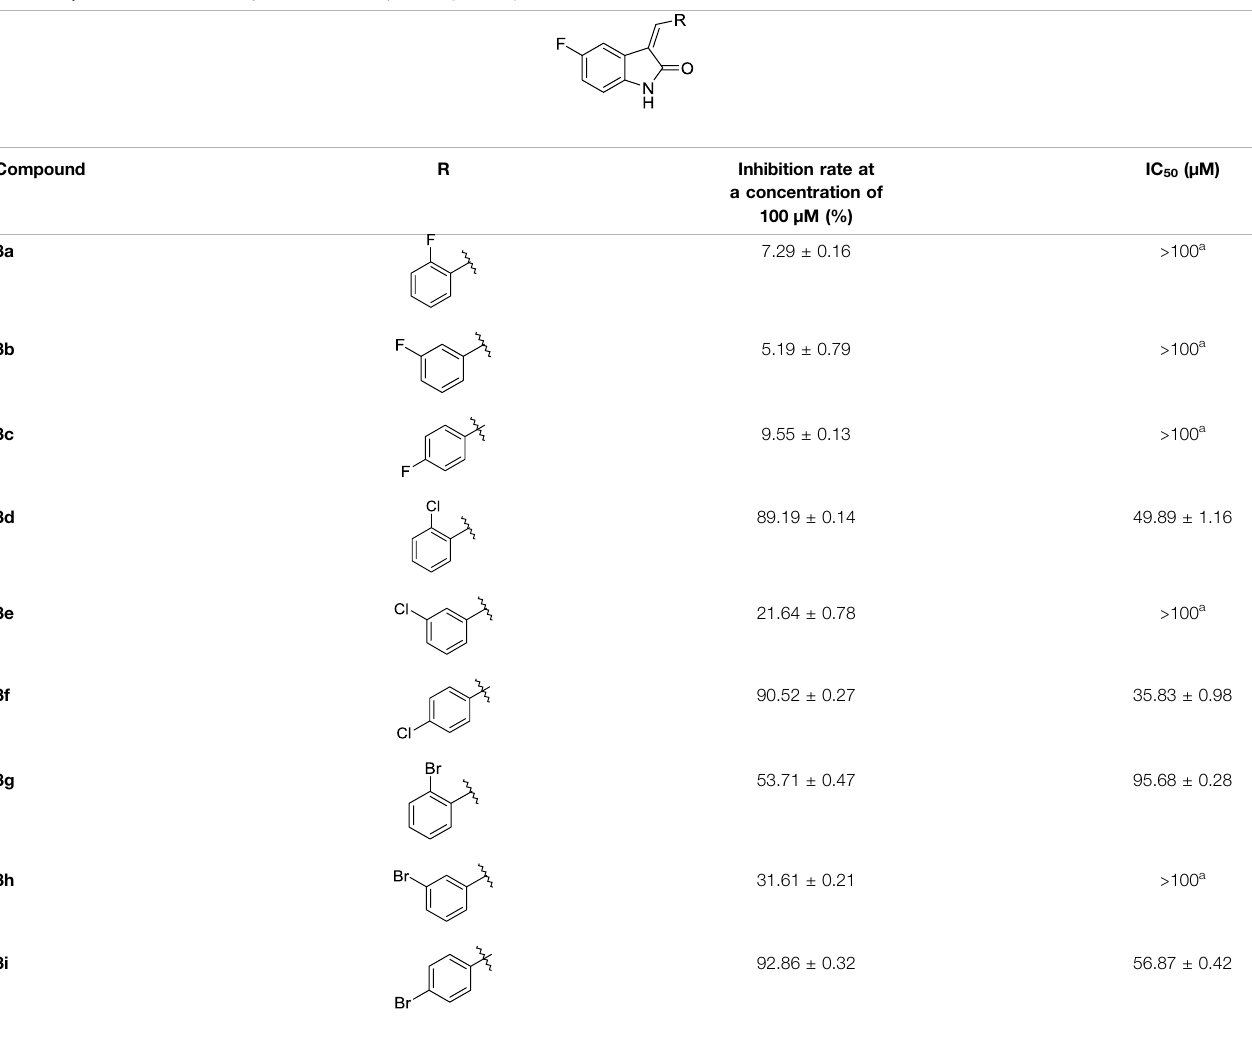
Compound R Inhibition rate at